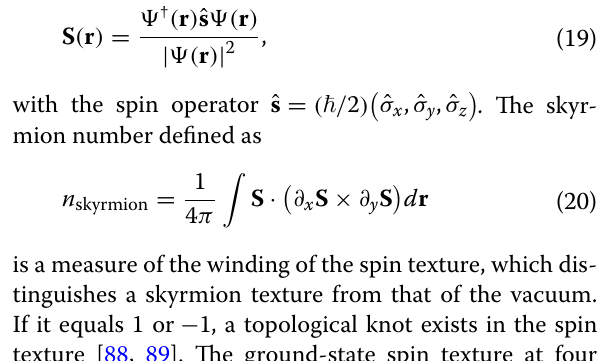
1 or 1 determined by the sign of is located either at l z = − the two-photon detuning. This gives rise to an additional first-order phase transition by continuously varying the two-photon detuning [55]. At strong coupling strength, 0 ground the system again jumps into the QAM l z = state as we discussed above.